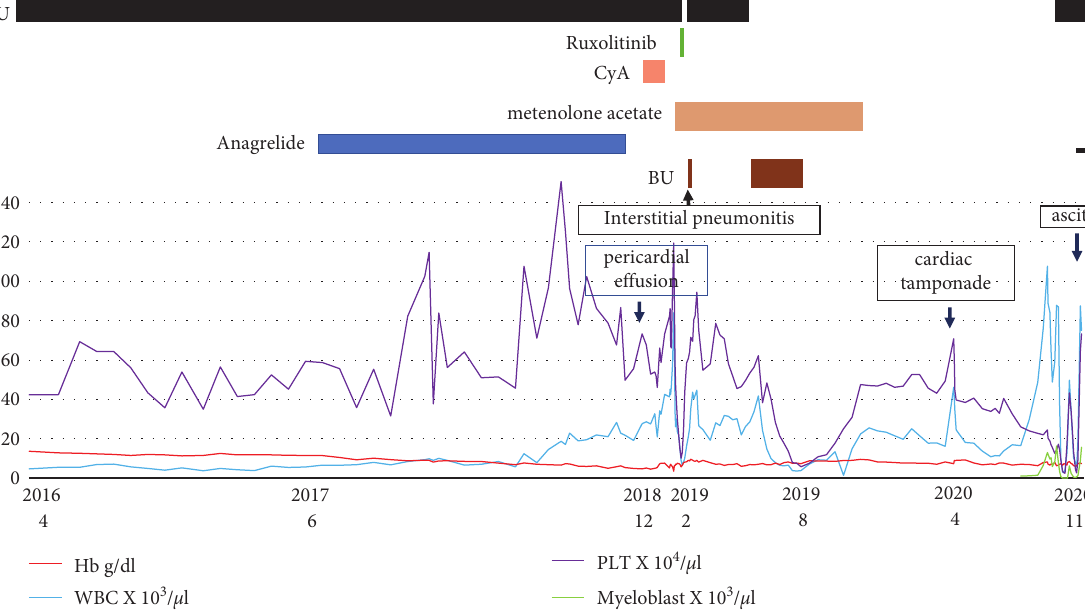
Figure 1: Clinical course. HU, hydroxyurea; CyA, cyclosporine; BU, busulfan; Hb, hemoglobin; WBC, white blood cell; PLT, platelets.